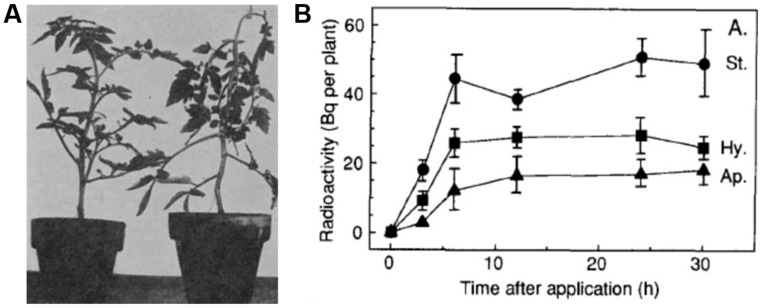
1-Aminocyclopropane-1-carboxylic acid transport in plants. (A) The epinastic response of tomato plants treated with ethylene gas as first observed by Doubt (1917). Figure reproduced from Doubt (1917). (B) ACC translocation via the phloem was demonstrated by measuring total radioactivity over time in the stem (St.), hypocotyl (Hy.), and apex (Ap.) after the foliar application of radioactive ACC to the oldest leaf (leaf 1) of 21 day old cotton plants. Figure reproduced from Morris and Larcombe (1995).